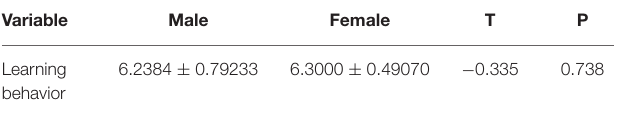
TABLE 3 | The independent sample T -test of gender online learning behavior.